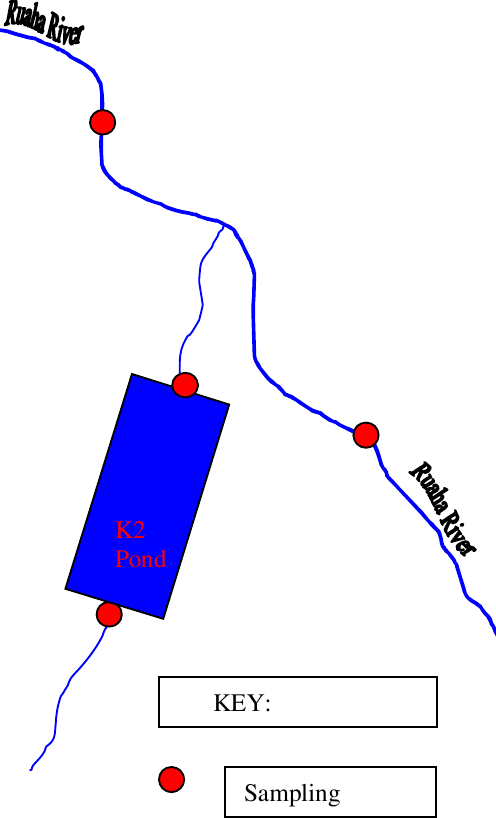
Figure 3: Schematic layout showing sampling locations Table 2: Analysed parameters and method of analysis used